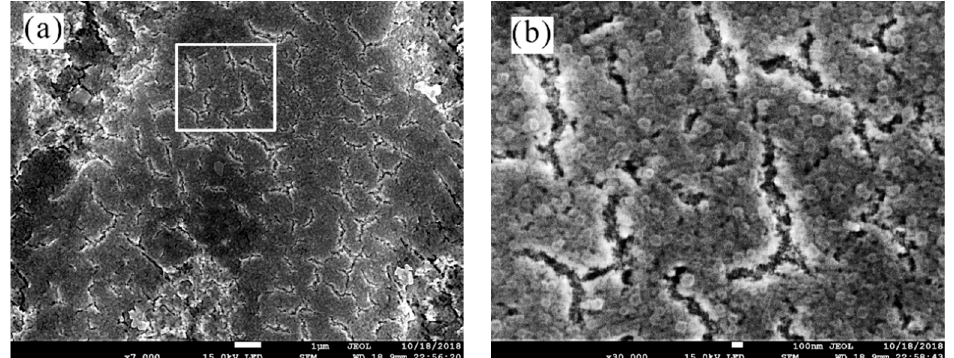
Figure 6. SEM micrograph of a TCC on Zn55Al formed by 180 s at 40 ° C in TCP bath with different magnification: ( a ) 7000×; and ( b ) 30,000×.